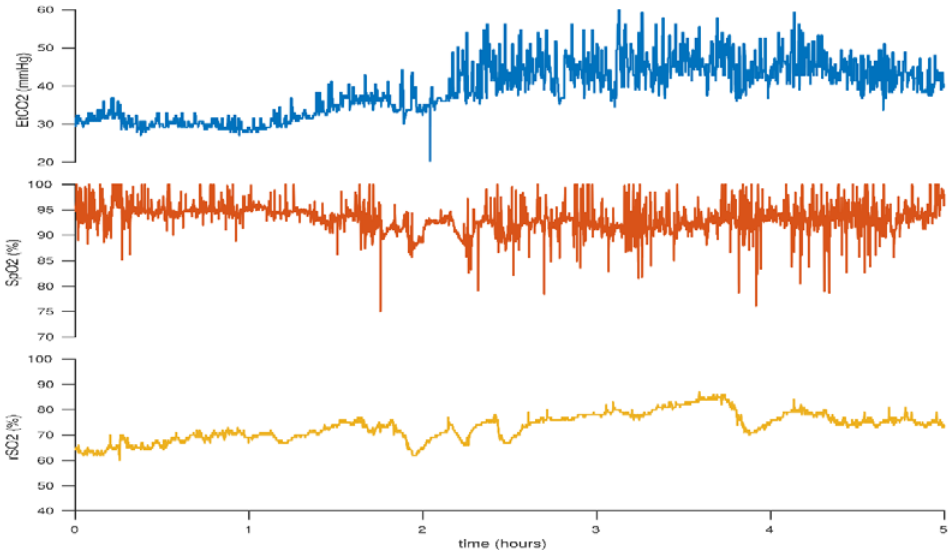
Figure 9. Initially low cerebral rSO 2 and end-tidal CO 2 (EtCO 2 ) levels which increase with increasing CO 2 . This figure reflects the case of a neonate born at 23 + 6 weeks gestation. BW 530 g, DOL 2.